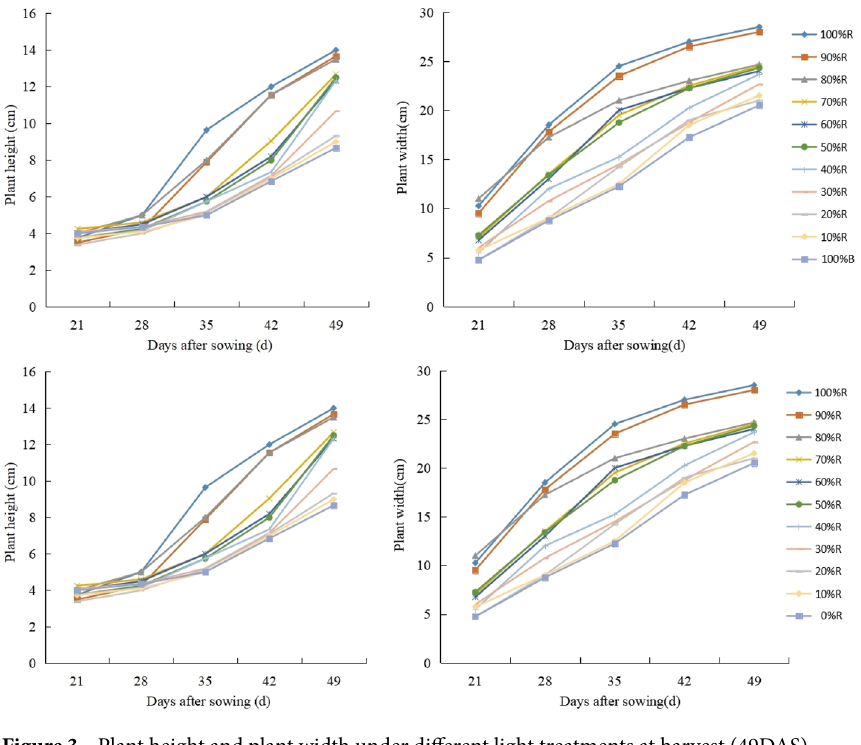
Figure 3. Plant height and plant width under different light treatments at harvest (49DAS).